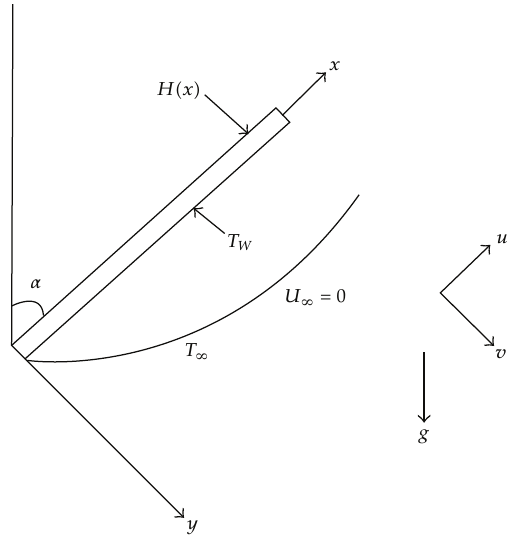
Figure 1: Geometrical configuration of the flow